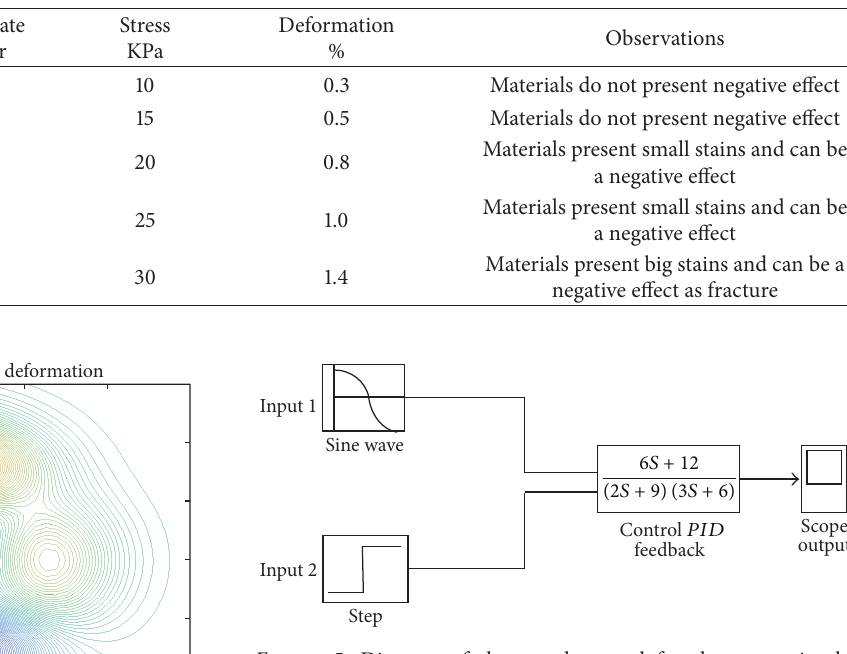
Figure 5: Diagram of the speed control for the motor in the biomechanical